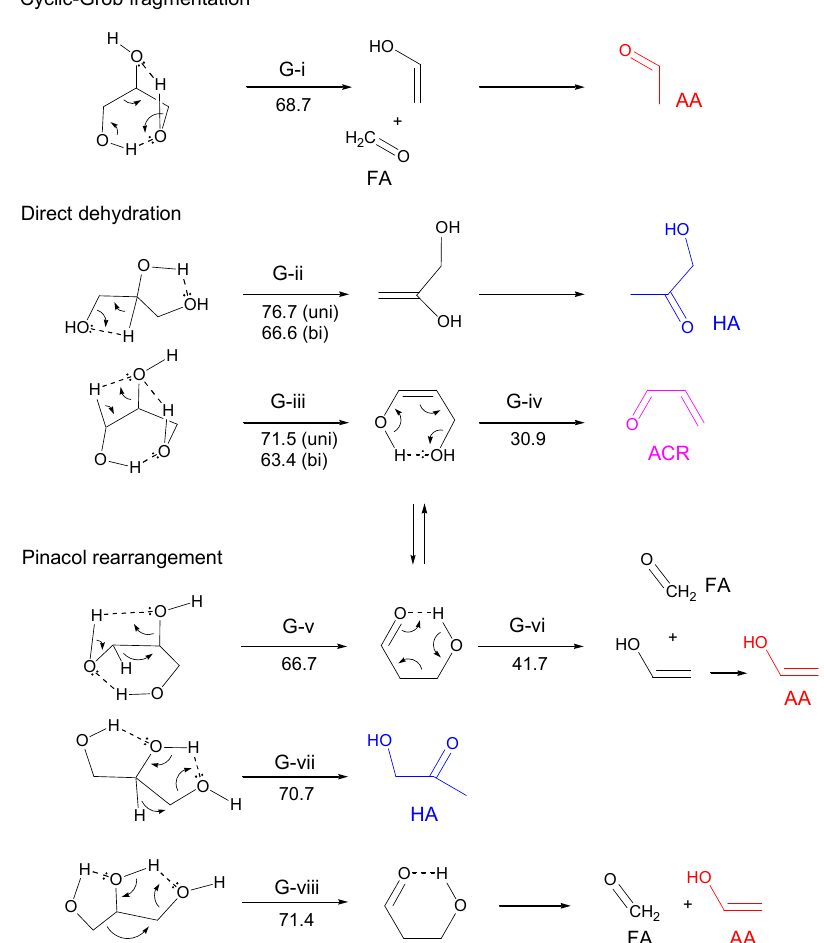
Figure 14. Possible heterolytic dehydration pathways for glycerol (Gly). The values next to the arrows represent the activation energies (kcal mol − 1 ), as calculated at the MP4(SDQ) // DFT(M06-2X) level. ACR, acrolein; HA, hydroxyacetone; AA, acetaldehyde; FA, formaldehyde; uni, unimolecular mechanism; and bi, bimolecular mechanism.